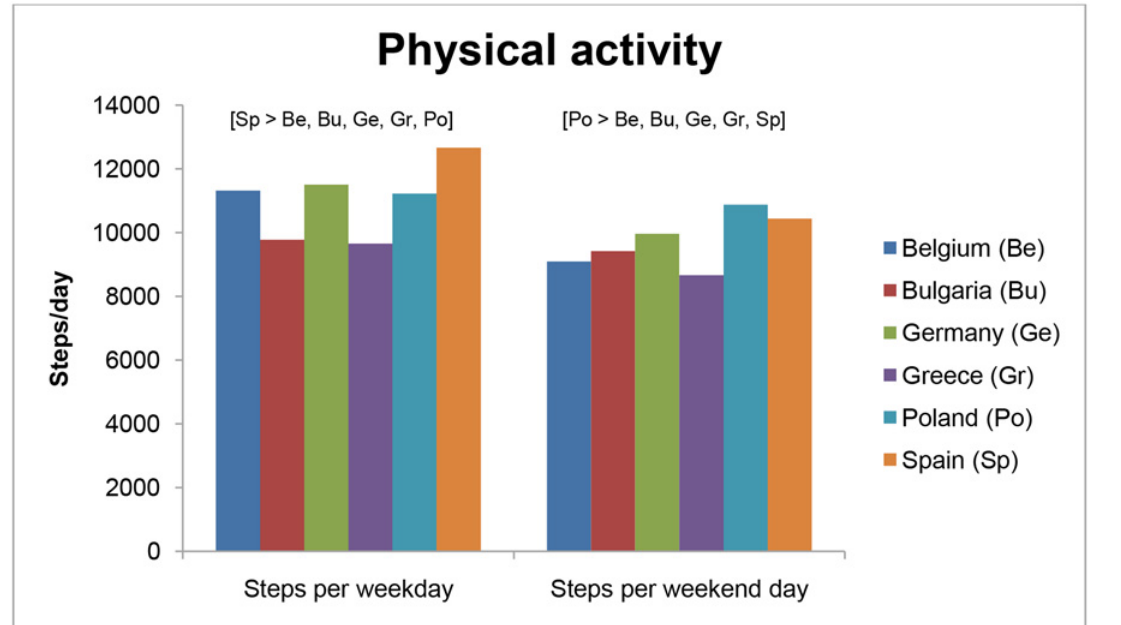
Fig 1. Differences in preschoolers ’ physical activity across countries.